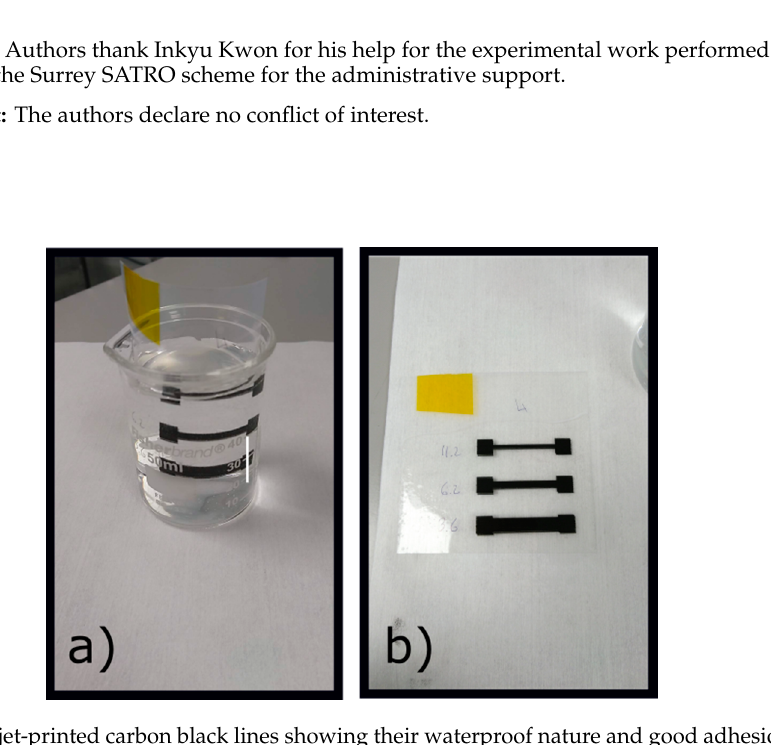
Figure A1. Inkjet-printed carbon black lines showing their waterproof nature and good adhesion to the PET substrate. ( a ) Dipping into the water. No dissolution of the ink was observed and, ( b ) after 10 min in the water, the measured resistance were the same as before the immersion.